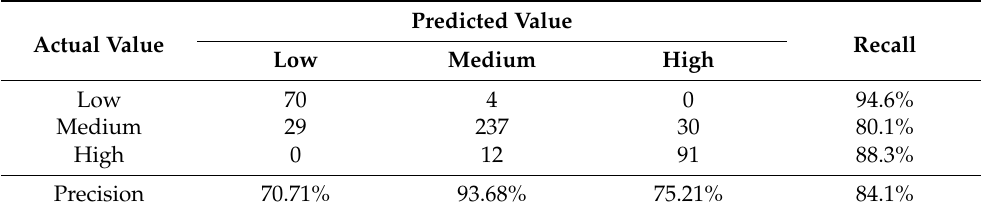
Table 4. Confusion matrix for three